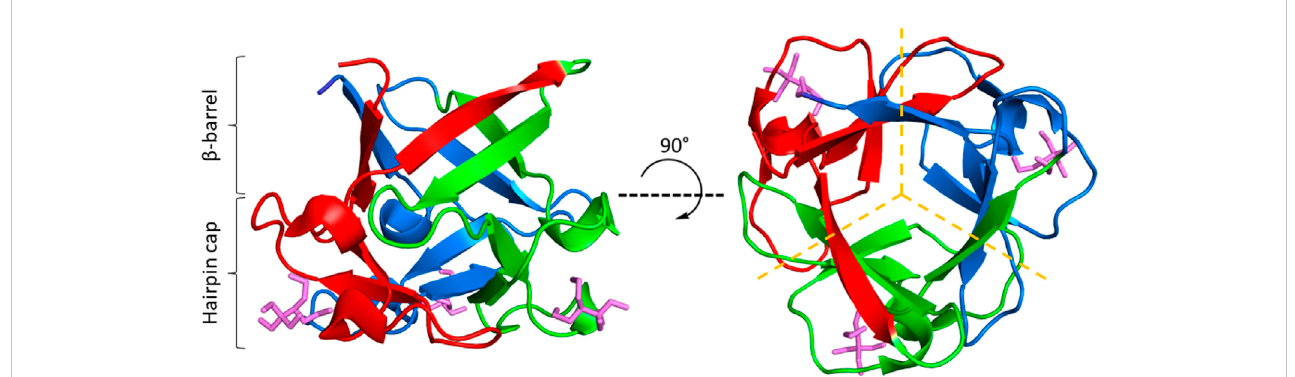
FIGURE 1 The β -trefoilfold. ThreeFoil(PDB ID:3PG0)isarepresentativeofthe β -trefoil fold. β -trefoilsconsistof12 β -strandsarranged ina β -barreland a β -hairpin cap (left). β -strands are connected by loops and turns of variable length. β -trefoils bind diverse ligands, often through their loops (ligands shown in purple). β -trefoils display internal pseudo three-fold symmetry (right). Symmetric trefoils are indicated by dashed yellow